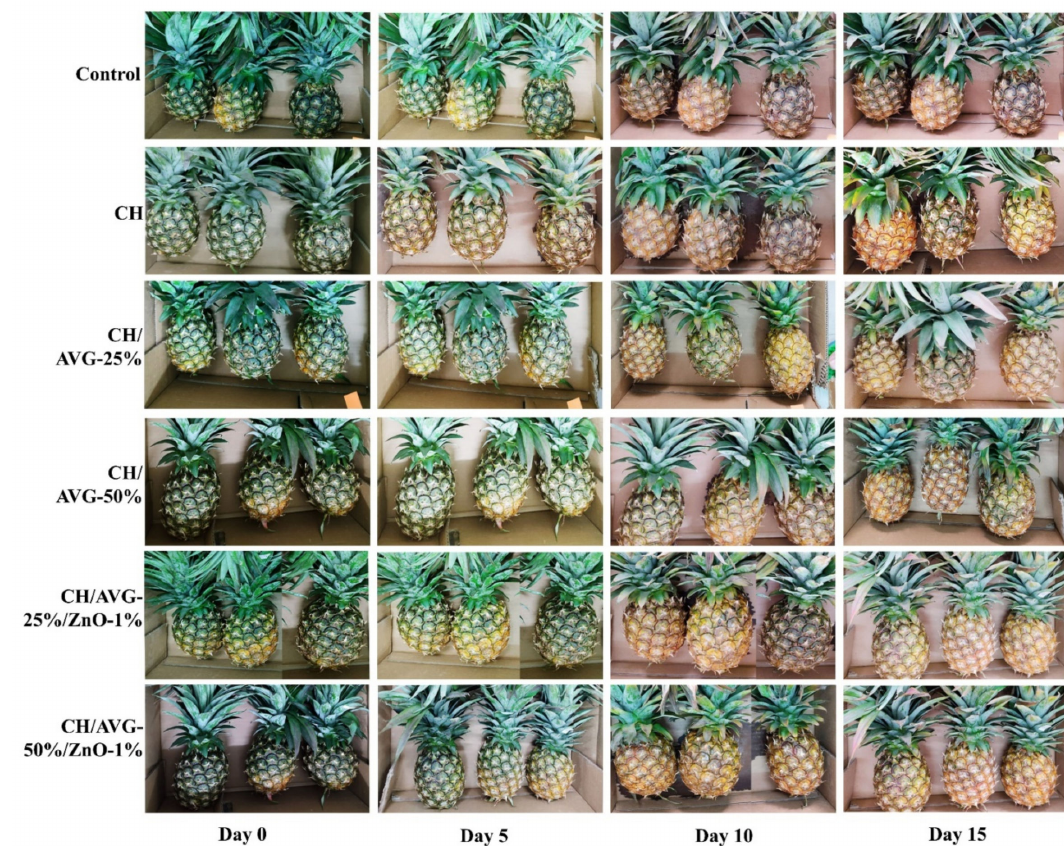
Figure 3. Effect of chitosan-based coatings on color, ripening, and maturity of pineapple fruits during 15 days storage under ambient condition.